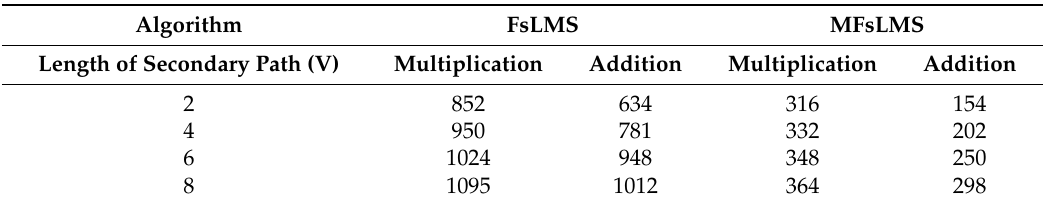
Table 1. Computational